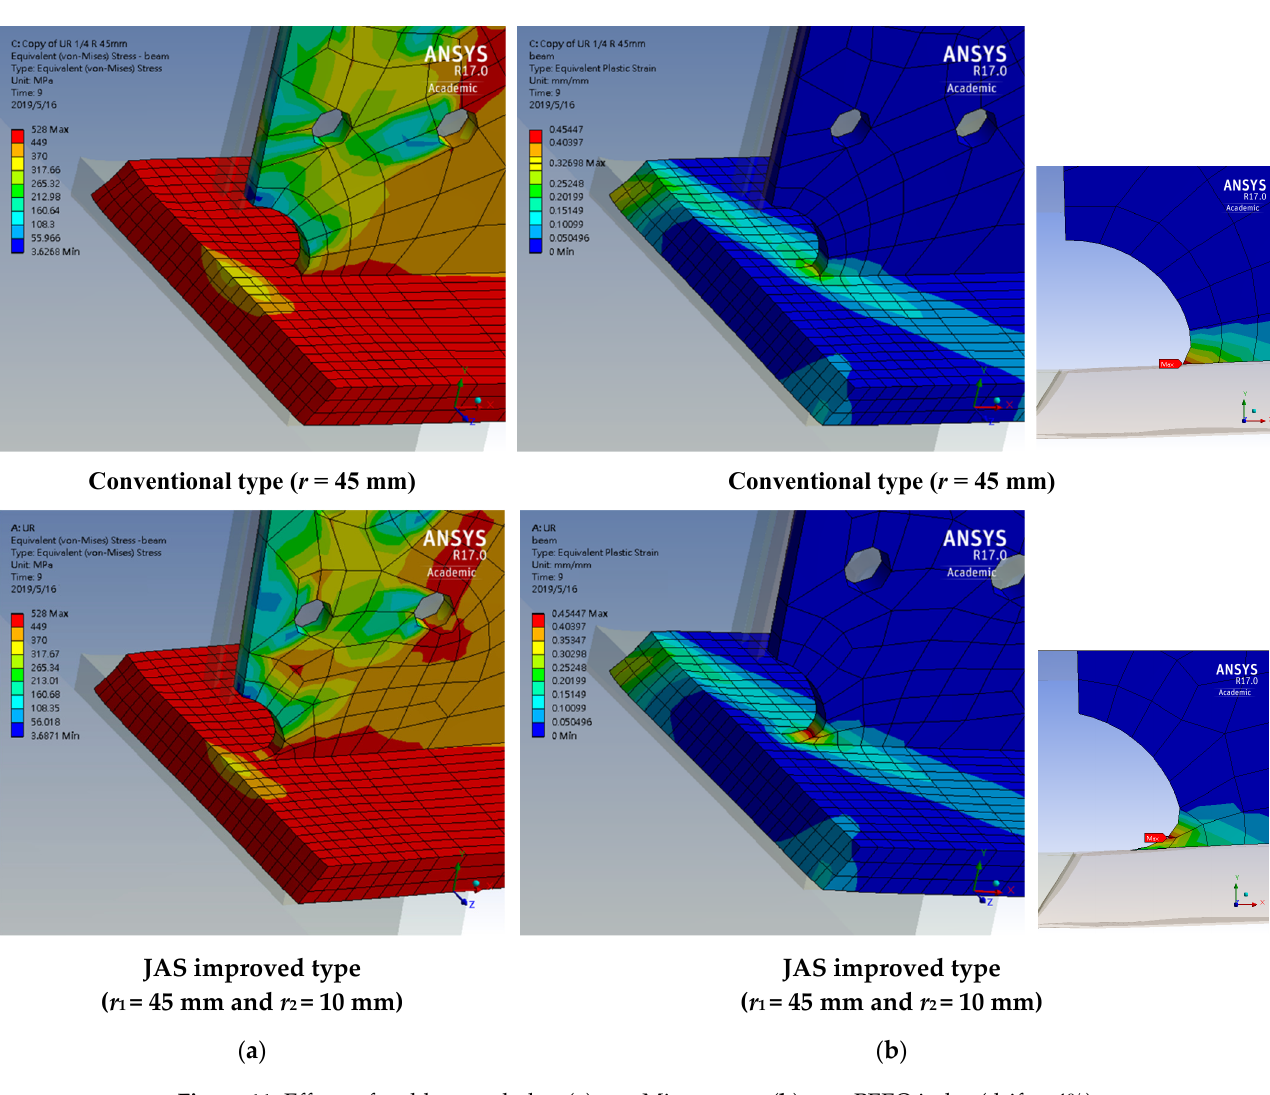
Figure 11. Effects of weld access holes: ( a ) von Mises stress, ( b ) max PEEQ index (drift = 4%).